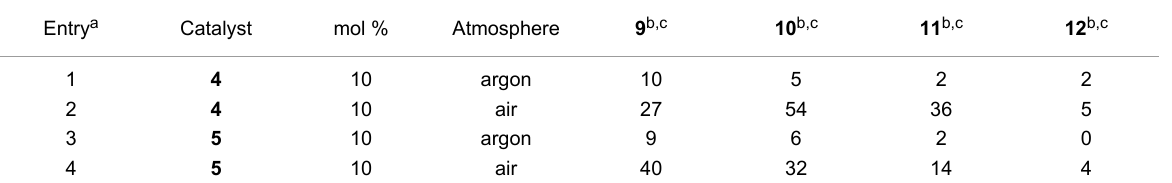
Table 1: Catalytic allylic amination of cyclohexene (Scheme 1). Reaction conditions: catalyst 4 or 5 (7 μ mol) and cyclohexene (0.7 mL, 7 mmol) were dissolved in CH 3 CN (total volume 10 mL) and stirred at room temperature under air or argon atmosphere while BocNHOH ( 8 , 70 μ mol) was added, then stirring was continued overnight (18